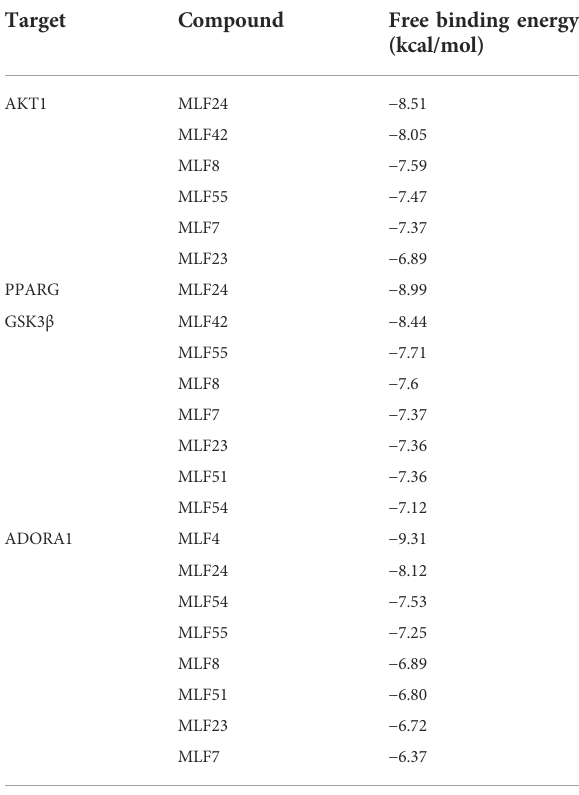
TABLE 5 Free binding energies of AKT1, PPARG, GSK3 β and ADORA1 with their corresponding active compounds.